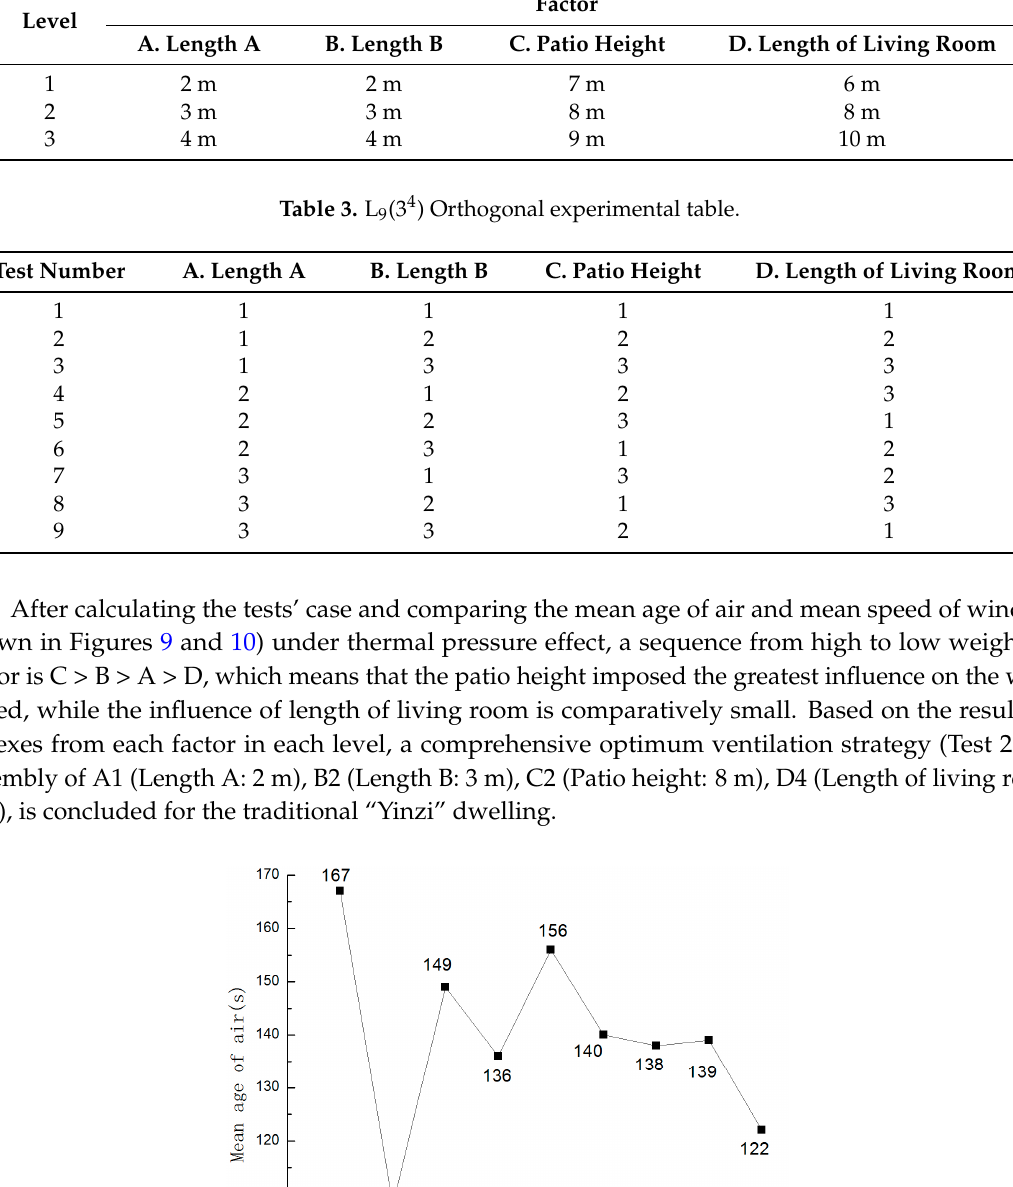
Table 3. L 9 (3 4 ) Orthogonal experimental table.